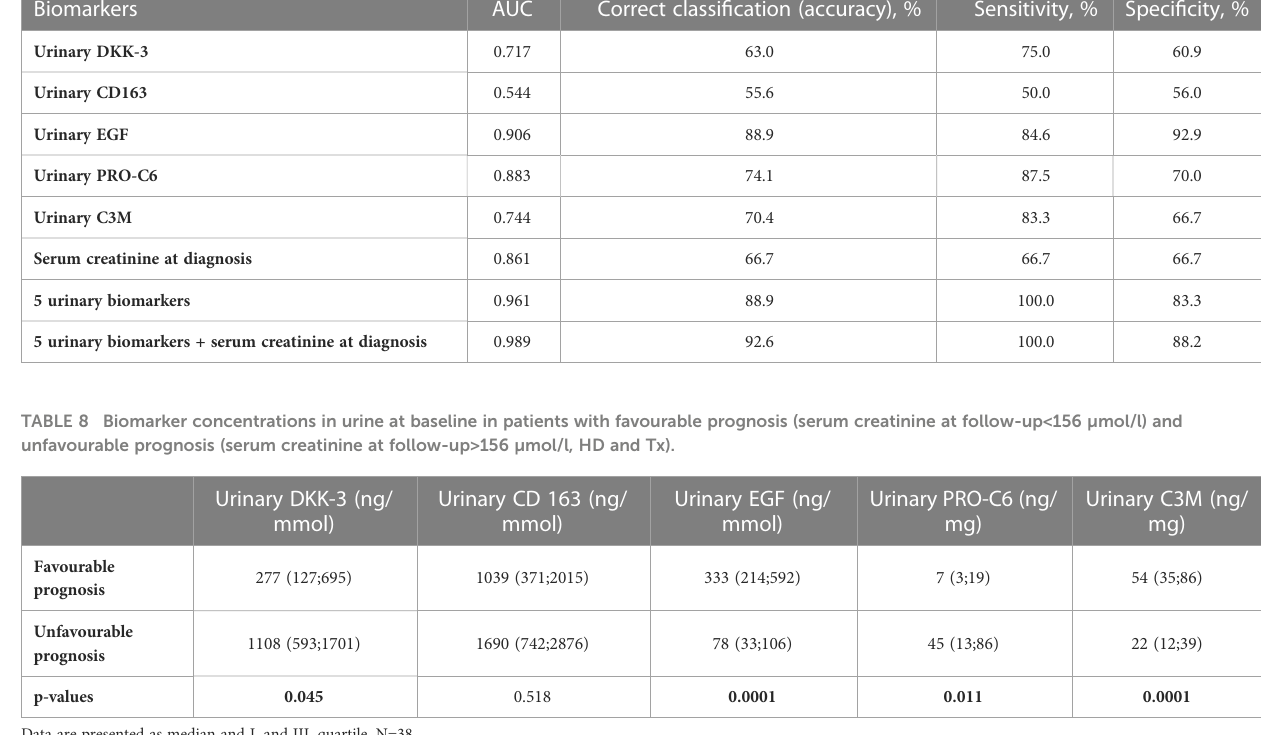
TABLE 7 AUC (from ROC), accuracy, sensitivity and speci fi city of the discrimination of the two groups (favourable and unfavourable kidney outcome) with 6 analysed biomarkers. Biomarkers